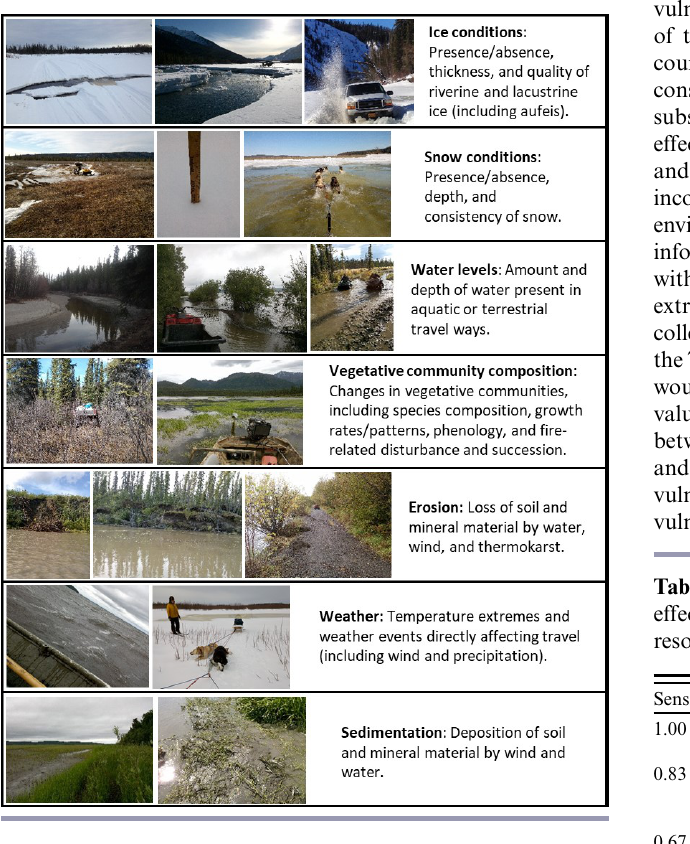
Fig. 2 . Descriptions and photographic examples of the seven condition classes developed by researchers of conditions associated with environmental changes that were reported to affect access to subsistence resources.